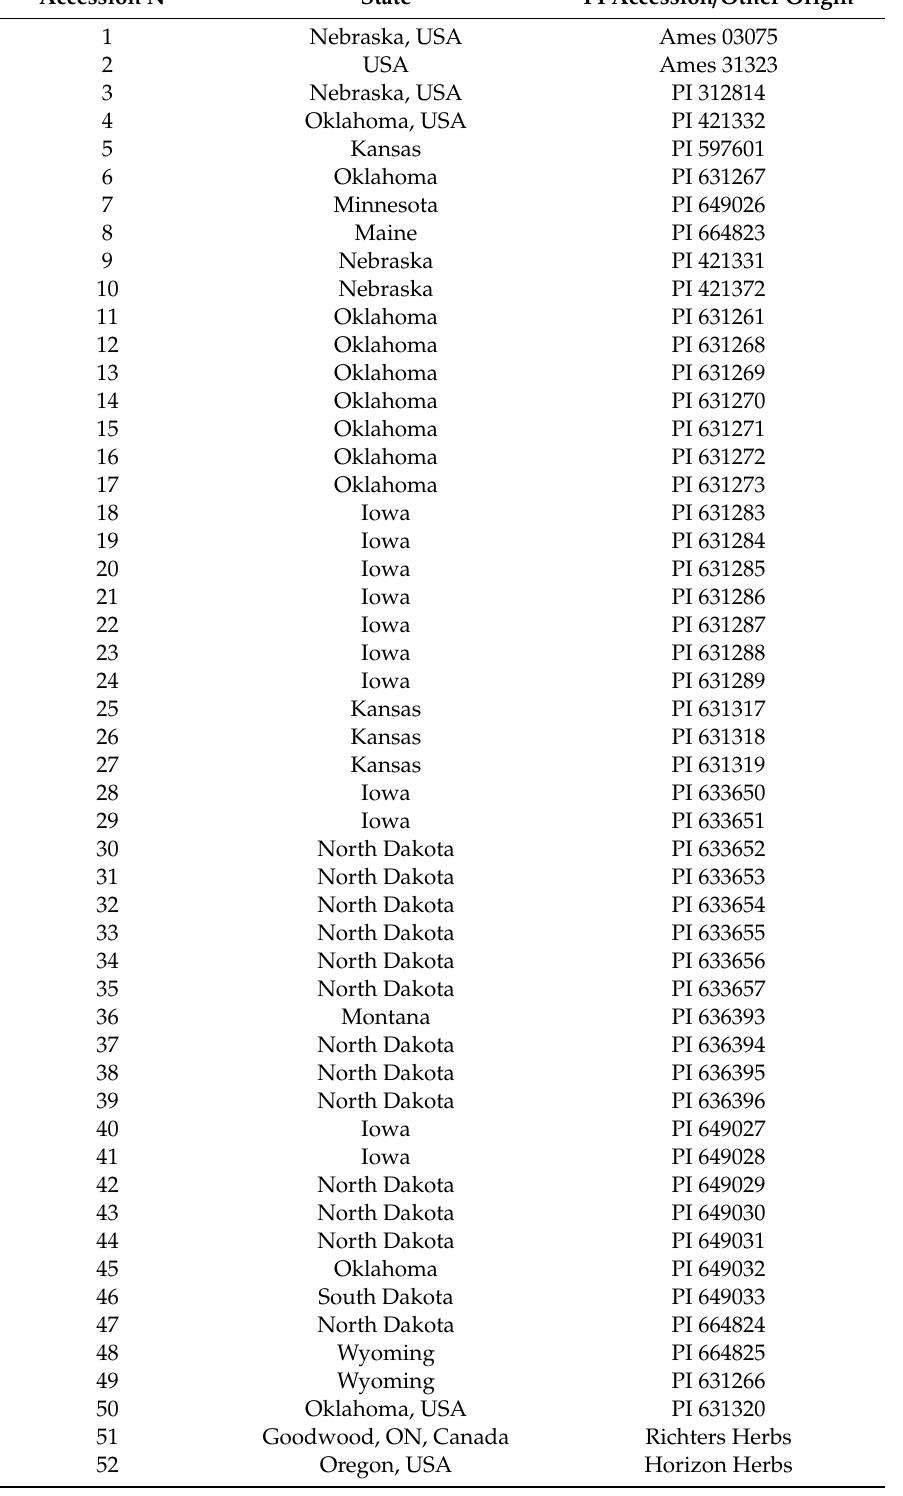
Table 1. List of E. angustifolia accessions. The country of origin and the PI accession / other origin are